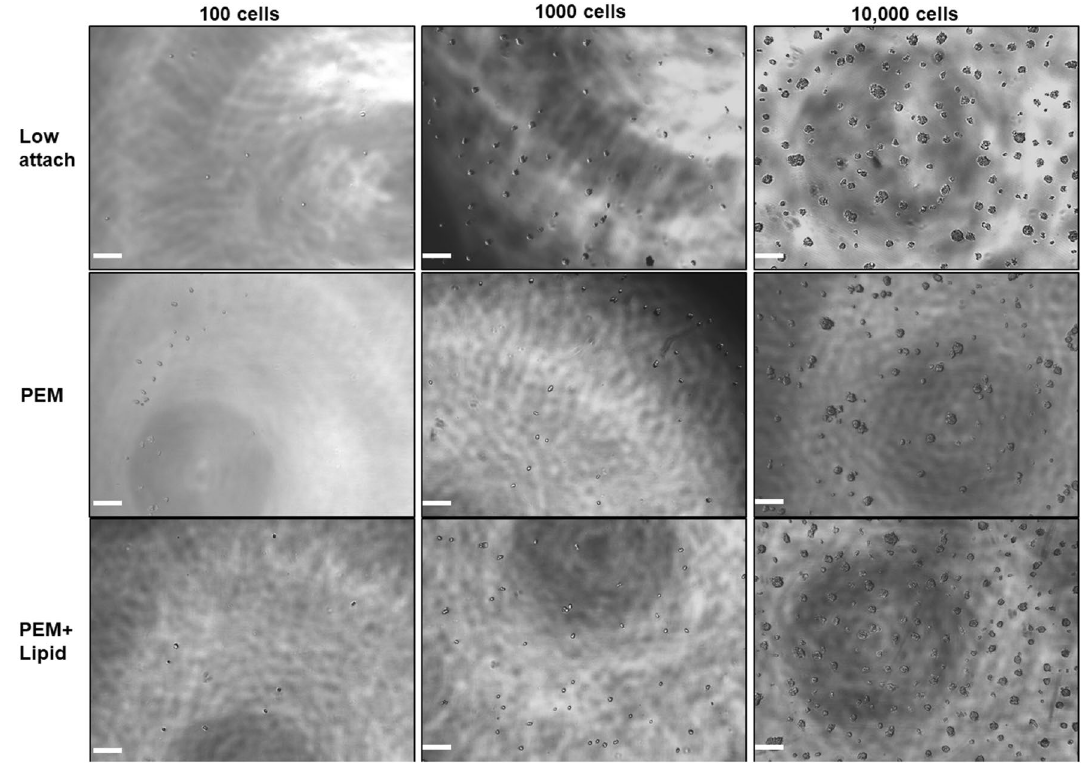
Figure 1. PEM + lipid coated plates can be used for mammosphere formation: FACS was used to seed single cell suspensions of MCF7 cells into 96 well low attach plates with the indicated surface treatments. Left column—100 cells/mL. Middle column—1000 cells/mL. Right column—10,000 cells/mL. Phase contrast images of resultant mammospheres for Day 1 (24 h) post seeding are shown. (×4 magnification, bar 200